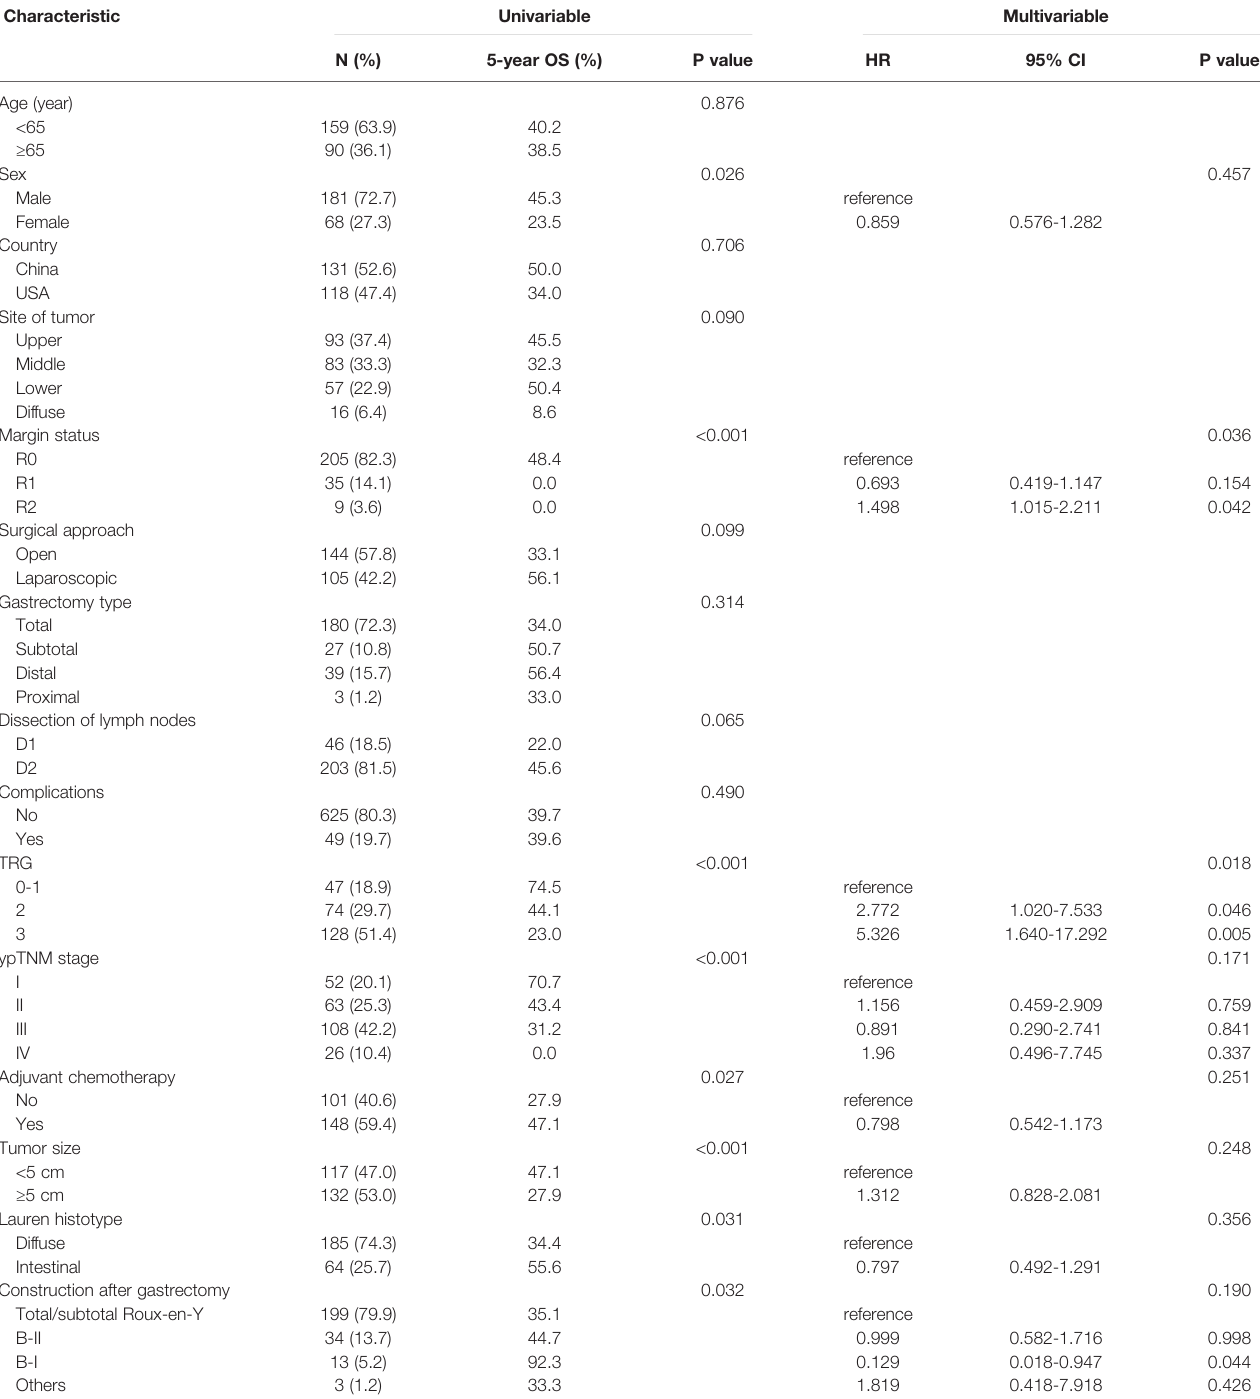
TABLE 2 | Univariate and Multivariate Analyses for Overall Survival